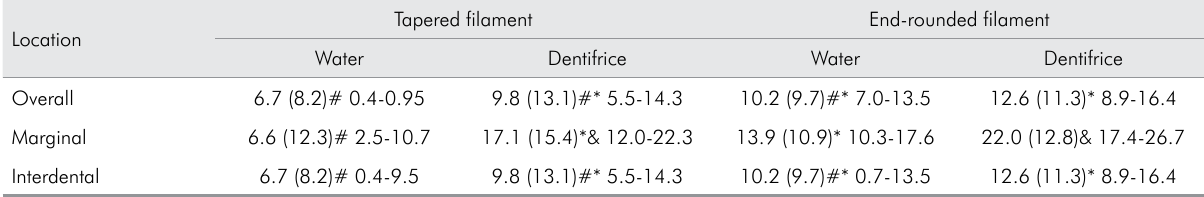
Table 4. Mean percentage increase (SD) and 95%CI in the number of sites with gingival abrasion according to lesion location.